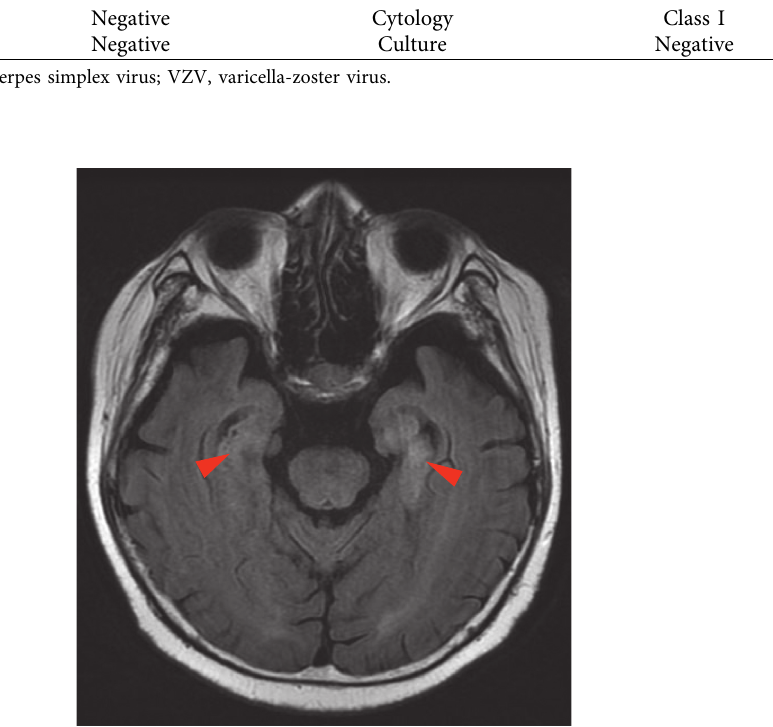
Figure 3: FLAIR image of brain MRI after development of neurological symptoms reveals slight improvement of high-intensity area in bilateral temporal lobes (red